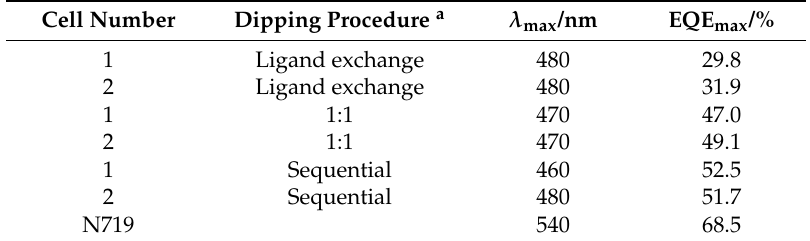
Table 4. EQE maxima for duplicate DSSCs containing dyes [Cu( 3 )( 4 )] + on the day of cell fabrication compared to